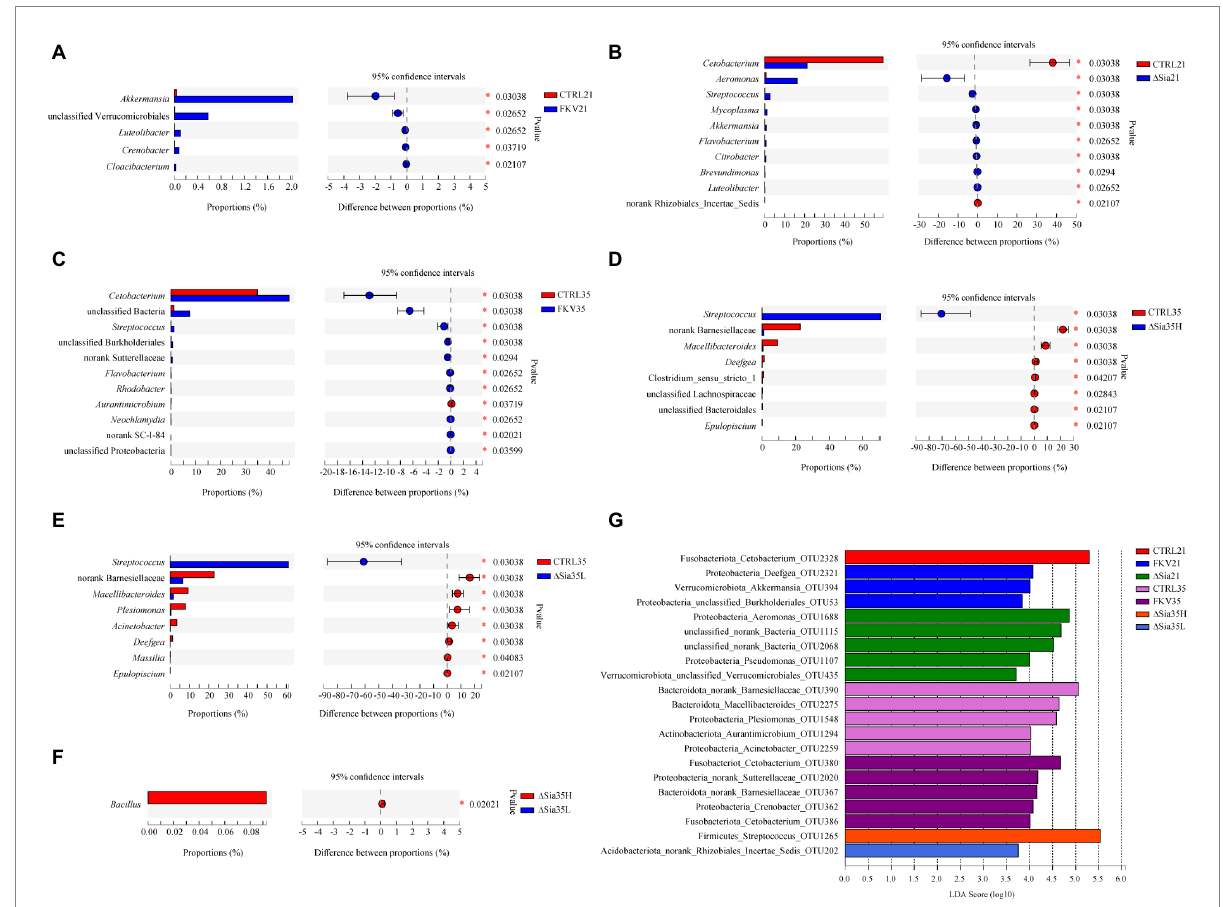
FIGURE 3 Analysis of differences in community composition at the genus level by the Wilcoxon rank-sum test with 95% confidence intervals (false discovery rate) between (A) CTRL21 and FKV21, (B) CTRL21 and ∆ Sia21, (C) CTRL35 and FKV35, (D) CTRL35 and ∆ Sia35H, (E) CTRL35 and ∆ Sia35L, and (F) ∆ Sia35H and ∆ Sia35L. (G) LEfSe (all-against-all) was performed to identify differentially abundant OTUs among different groups (LDA > 2) on the basis of the nonparametric Kruskal–Wallis H test, and LDA was used to determine the effect size of differentially abundant taxa. The horizontal axis shows the LDA scores, and the vertical axis shows OTUs with significant differences in abundance among different groups. High LDA scores are indicative of the great influence of species abundance on the differential effect. CTRL21, control group at 21 dpiv; FKV21, FKV group at 21 dpiv; ∆ Sia21, LAV ∆ Sia group at 21 dpiv; CTRL35, control group at 35 dpiv; FKV35, FKV vaccine group at 35 dpiv (14 days after the second immunization); ∆ Sia35H, LAV ∆ Sia group with a high serum antibody response at 35 dpiv (14 days after the second immunization); ∆ Sia35L, LAV ∆ Sia group with a low serum antibody response at 35